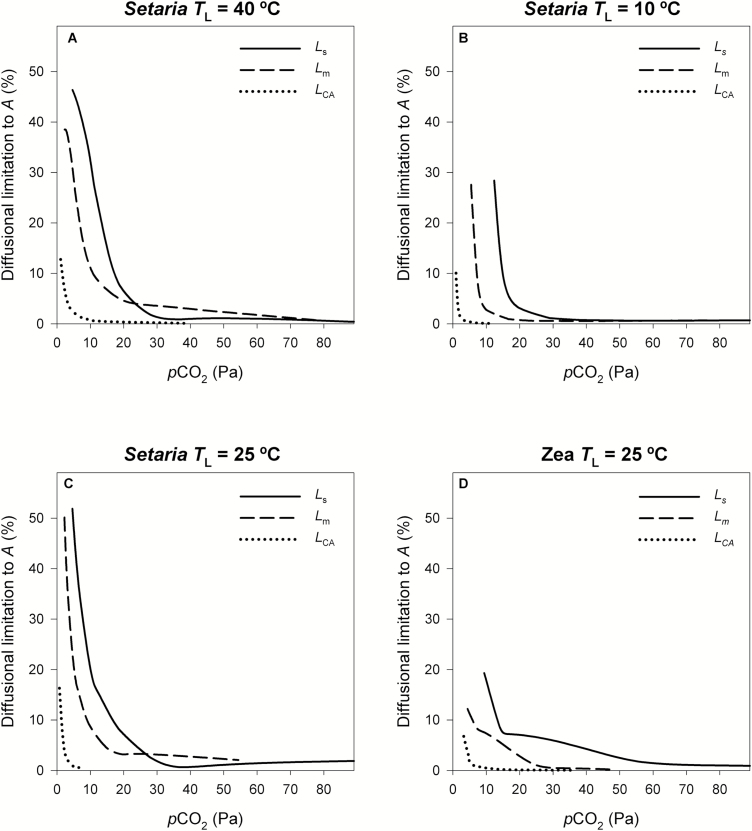
Diffusional limitation to photosynthetic rate (A) imposed by stomatal resistance (Ls, Eqn 11, solid line), mesophyll resistance (Lm, Eqn 12, dashed line), and carbonic anhydrase (LCA, Eqn 13, dotted line) as a function of the CO2 supply (pCO2) available for each (Ca, Ci, and Cm for Ls, Lm, and LCA, respectively). (A) Setaria viridis at TL=40 °C, (B) Setaria viridis at TL=10 °C, (C) Setaria viridis at TL=25 °C, and (D) Zea mays at TL=25 °C.